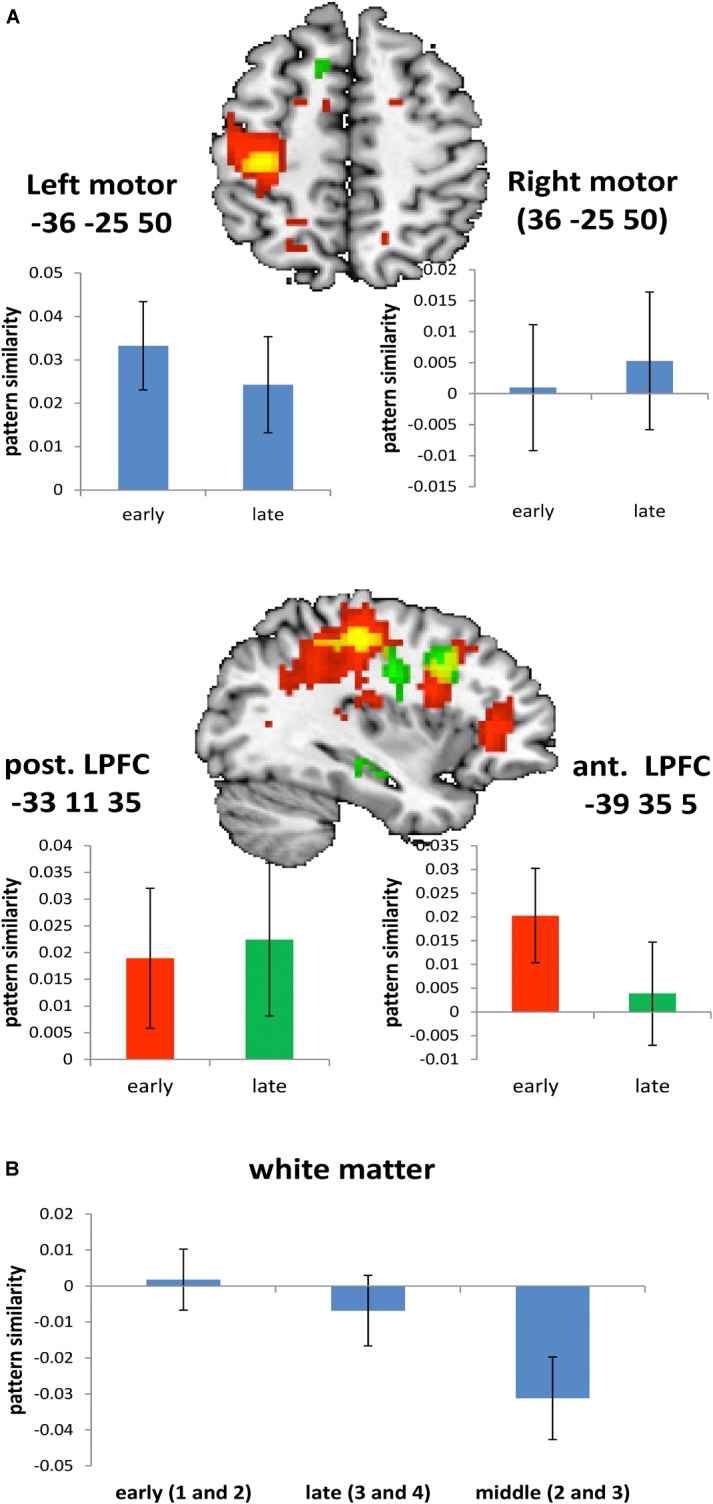
Pattern similarity results based on real data; error bars represent 90% confidence interval. (A) T-maps representing early stage (red) and late stage (green) pattern similarities and their overlap (yellow), each thresholded at t > 2.0 for visualization. (B) Searchlight pattern similarity results averaged across all white matter voxels.